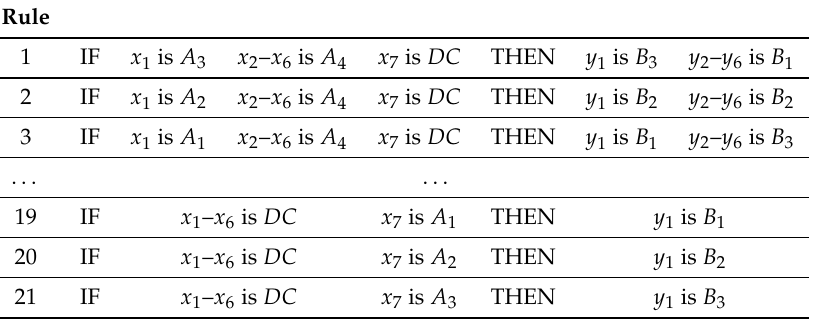
Table 1. Part of the rule